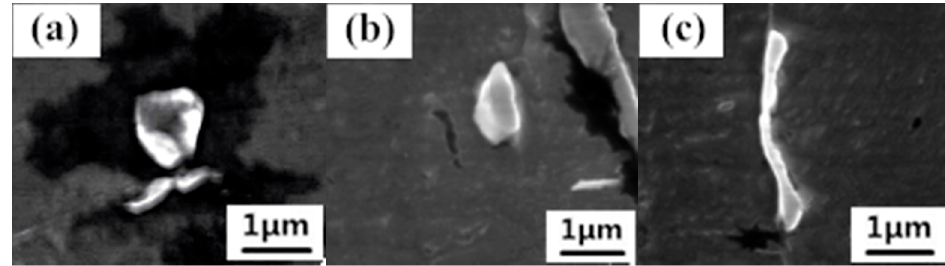
Figure 6. Typical morphologies of MnS inclusions in the specimens: ( a ) spherical; ( b ) spindle-shaped; and ( c ) thread-shaped.